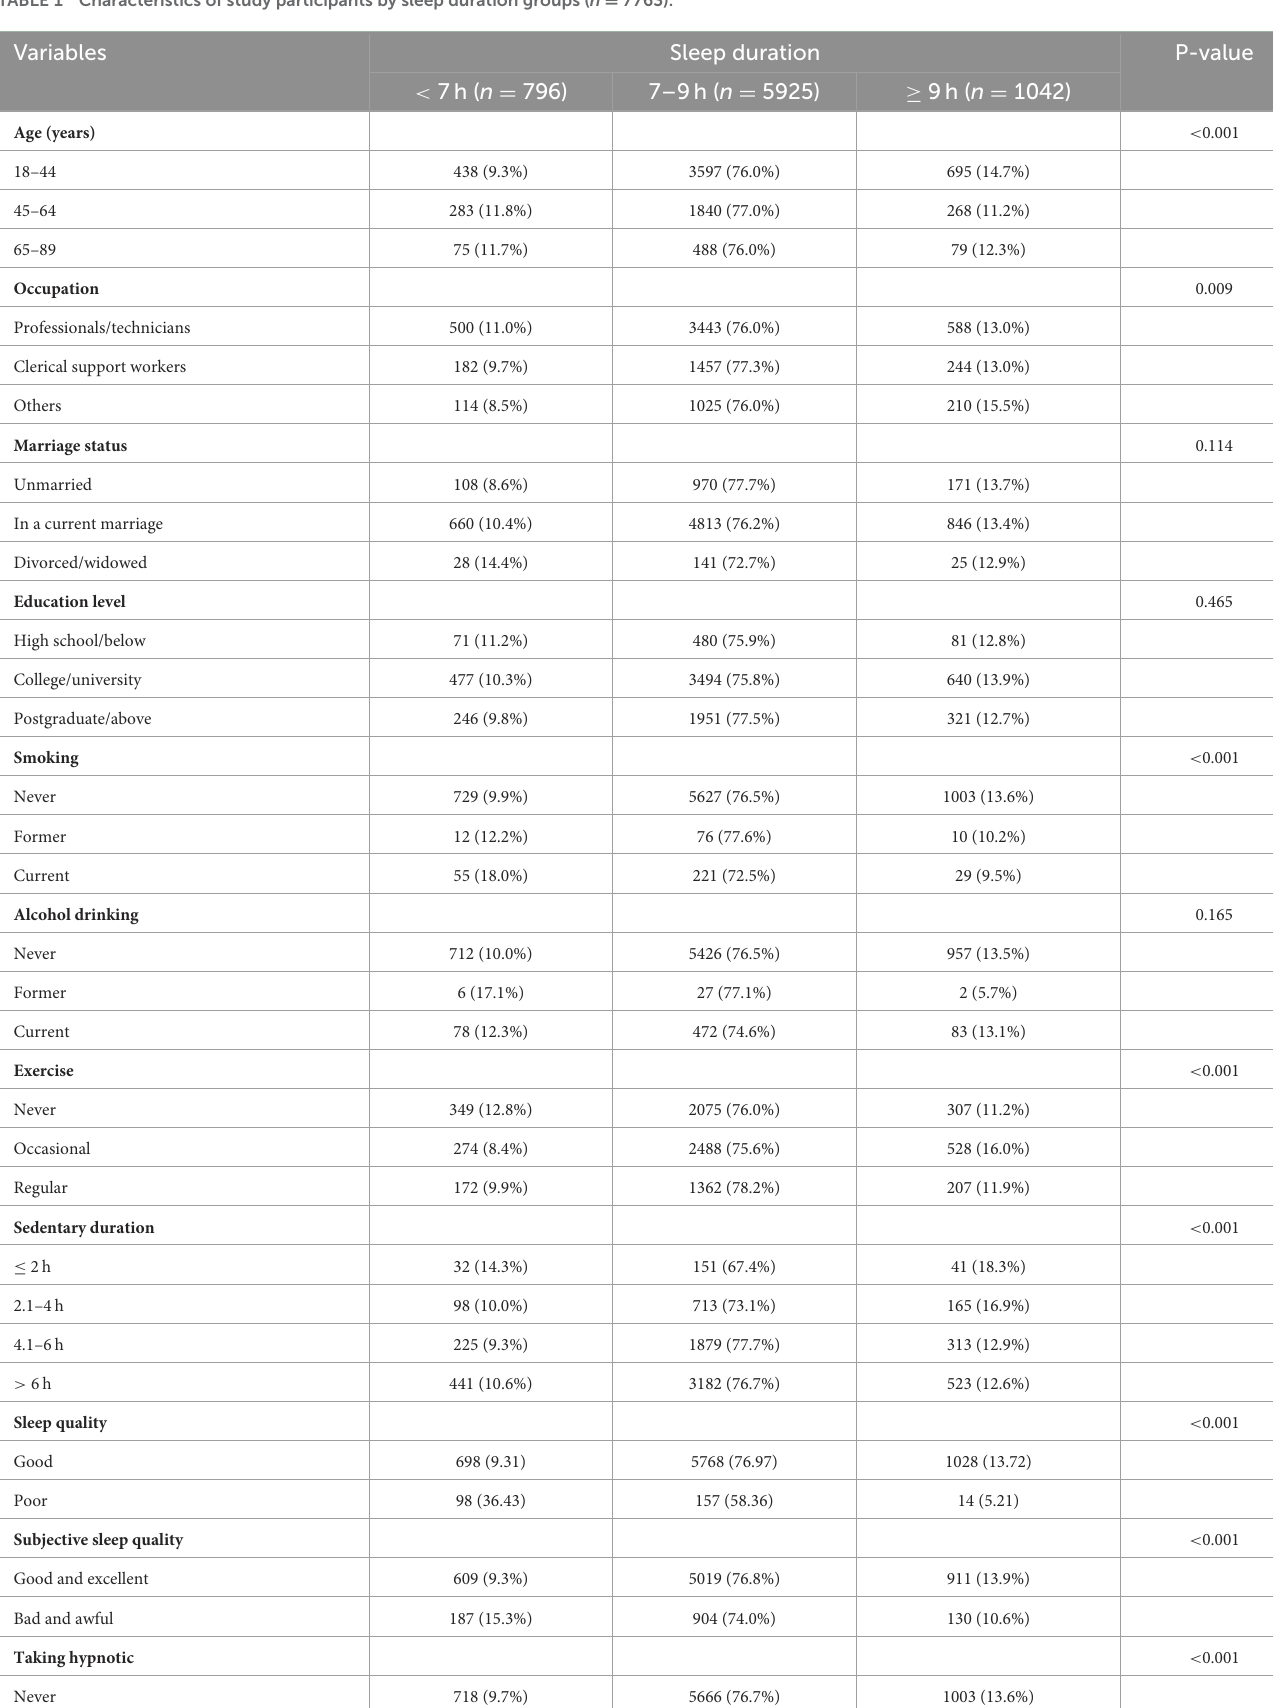
TABLE 1 Characteristics of study participants by sleep duration groups ( n =